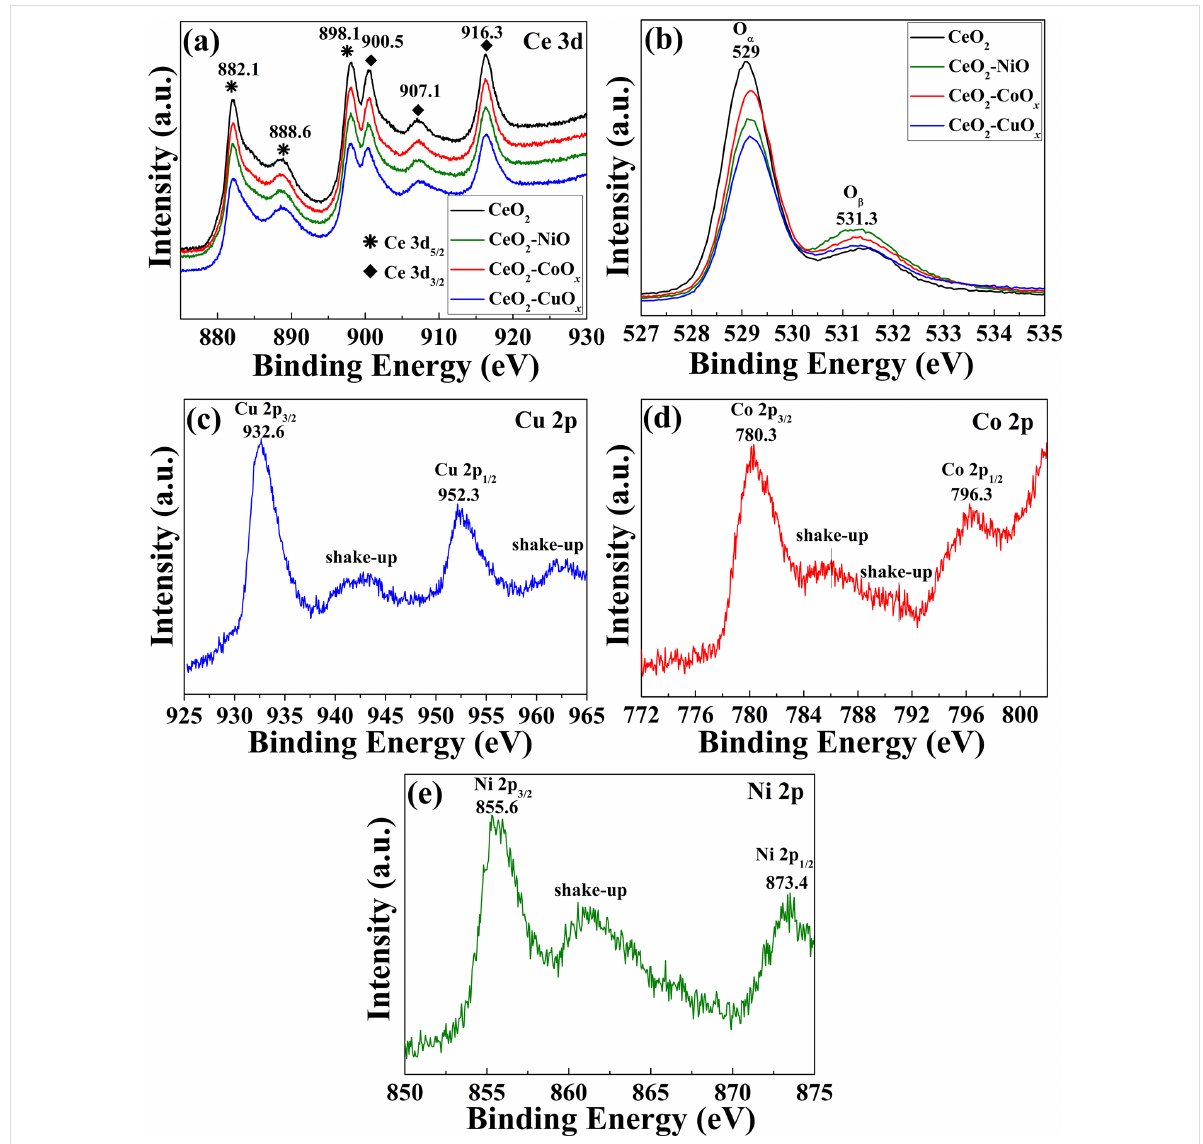
Figure 7: XPS spectra of Ce 3d (a), O 1s (b), Cu 2p (c), Co 2p (d) and Ni 2p (e) of the as-synthesized CeO 2 –MO x composite yolk–shell nanospheres.